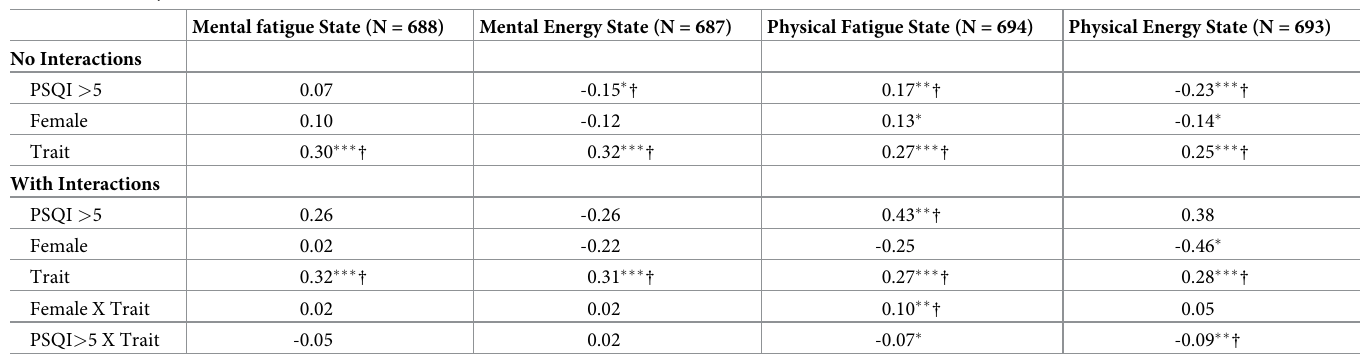
Table 2. Summary of interactions from overall models 1 .